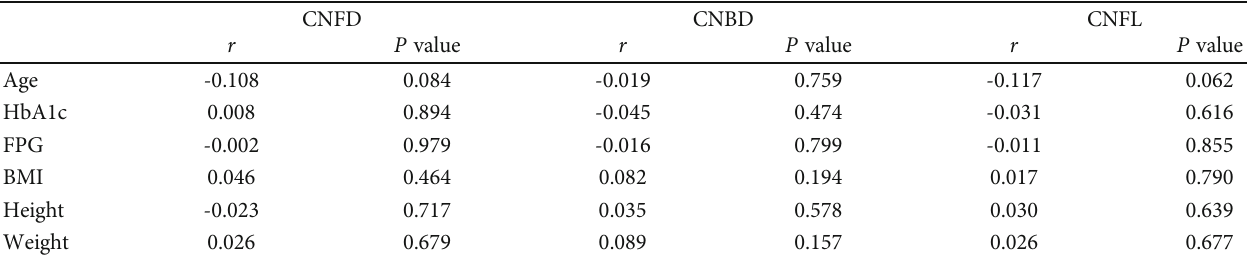
Table 2: Partial correlation between CCM measures and clinical variables (adjusted for sex).